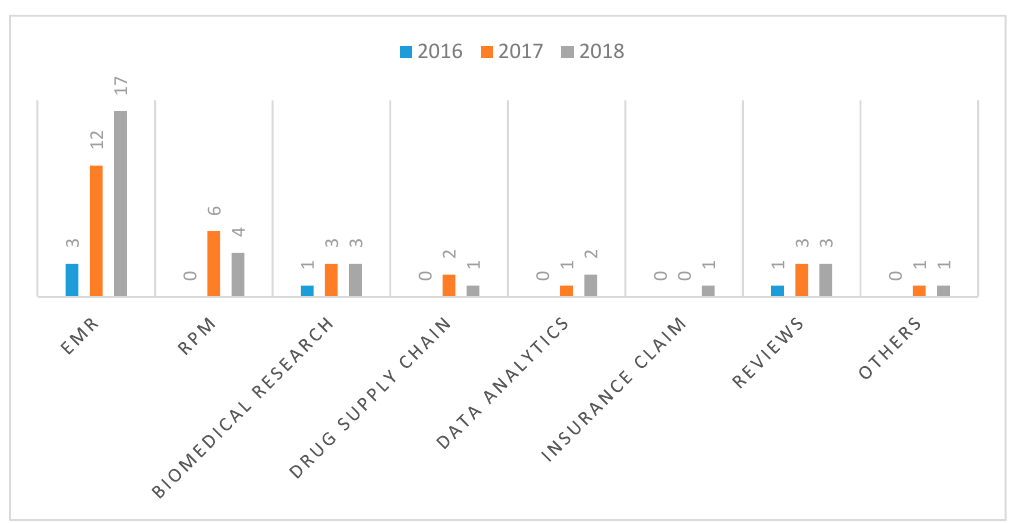
Figure 13. Classification of the selected papers showing publication trend from 2016 to 2018.